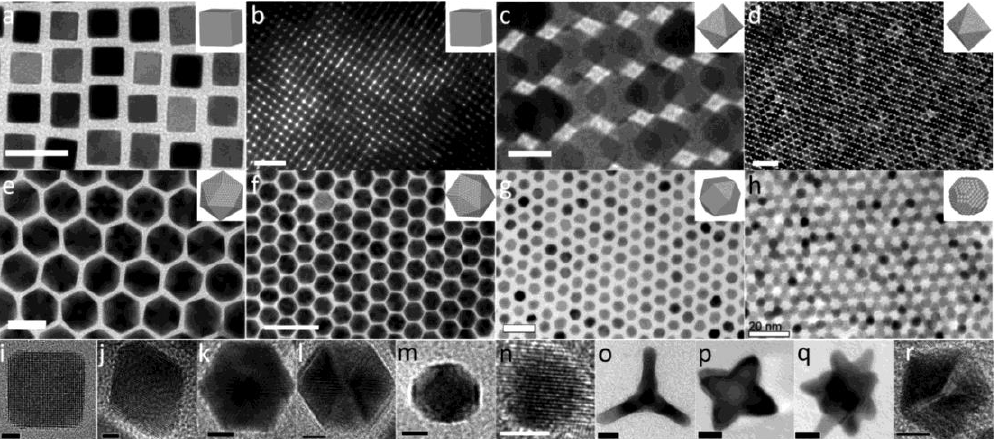
Figure 5. Pt NPs with different shapes: ( a , b , i ) cubes, ( c , d , j ) octahedrons, ( e , f , k , l ) icosahedrons, ( g ) cuboctahedrons, ( h , n ) spheres, ( m ) truncated cube, ( o ) tetrapod, ( p ) star-like octapod, ( q ) multipod, ( r ) 5-fold twinned decahedron. Scale bars: ( a , e , g , h ) 20 nm, ( b , d , f ) 50 nm, ( c , o , p , q ) 10 nm, 100 nm, ( i , j ) 2 nm, ( k , l , m , n , r ) 5 nm. Reproduced from [79], with permission from American Chemical Society, 2013.